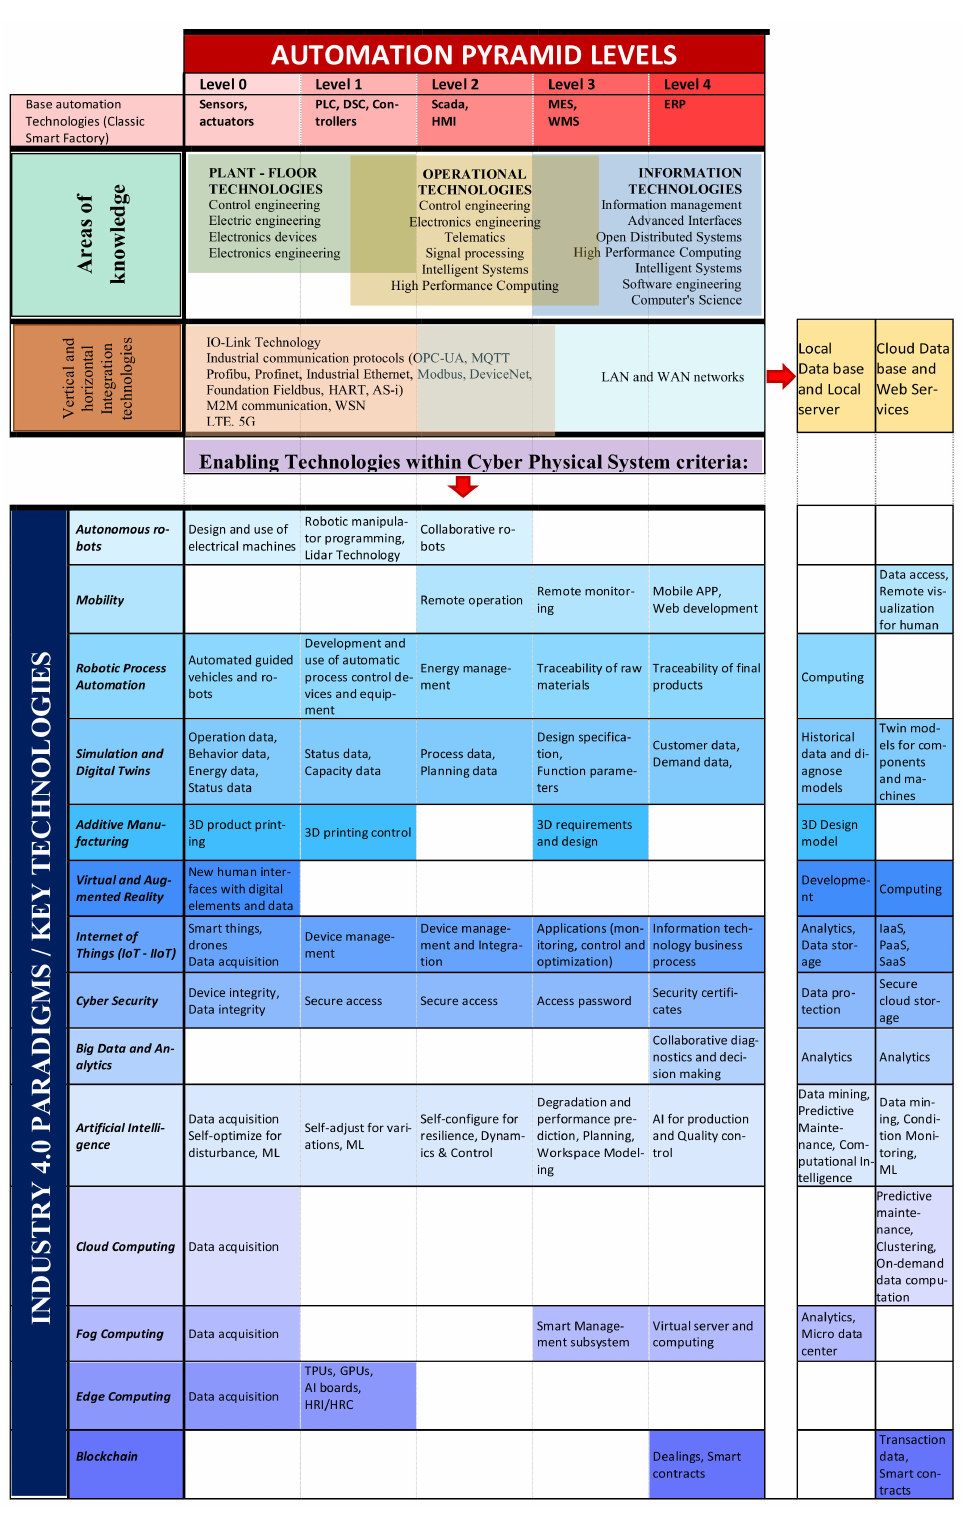
Figure 10. Proposed scheme of reorganization of Industry 4.0 criteria, paradigms, and key